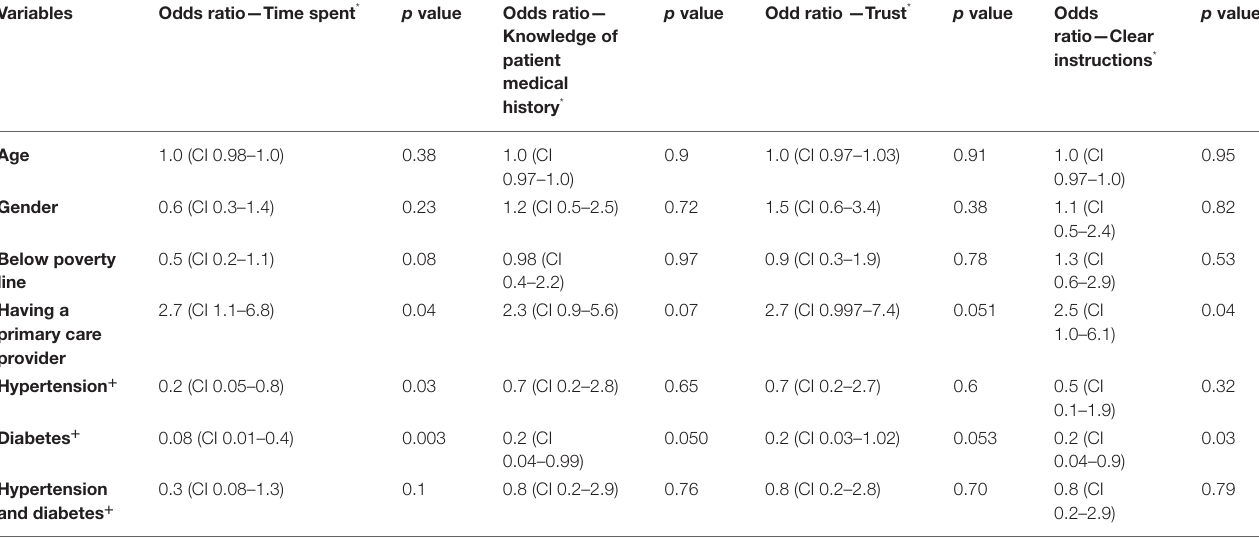
p ratio—Clear instructions *